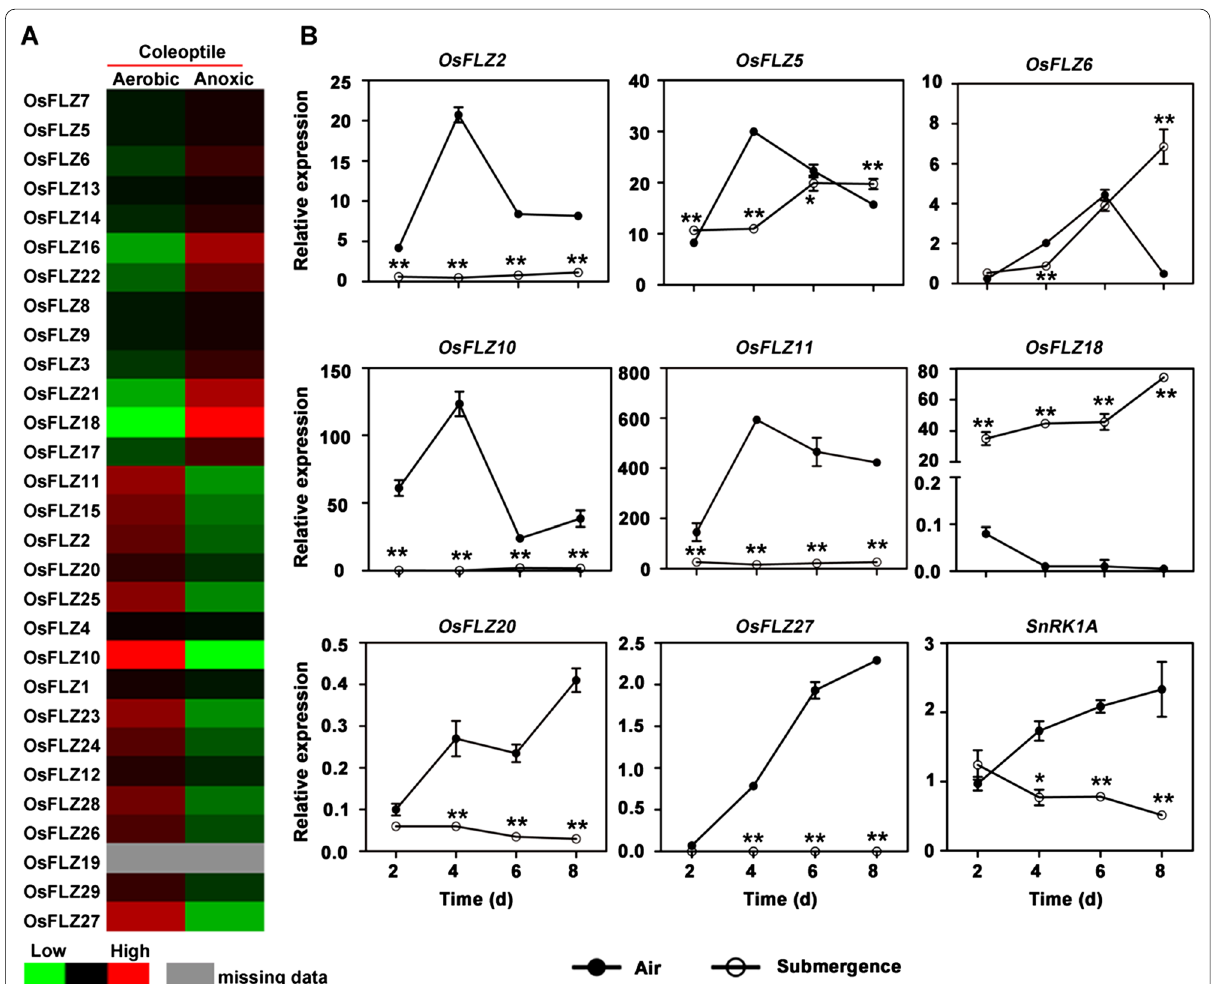
Fig. 5 Expression profiles of OsFLZ genes under submergence condition. a Heatmap based on the microarray data with respect to the relative expression levels of OsFLZ genes in coleoptile under aerobic and anoxic conditions (Lasanthi-Kudahettige et al. 2007). b Validation of the gene expression of OsFLZs over time after submergence treatment by qRT-PCR. The coleoptiles from germinated seeds were then collected over a time course indicated. The transcription levels of rice OsEF1α were used as internal controls. * p < 0.05, ** p < 0.01, Student’s t